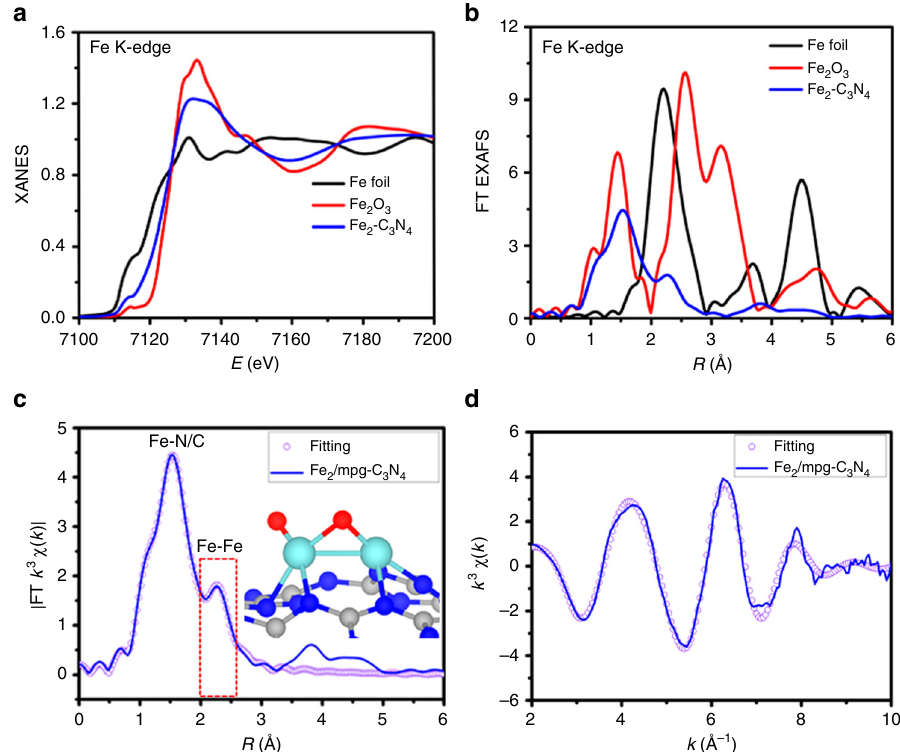
Fig. 2 X-ray absorption analysis of Fe K-edge. a XANES spectra at the Fe k-edge of Fe 2 /mpg-C 3 N 4 , Fe 2 O 3 , and Fe foil. b Fourier transform (FT) at the Fe k- edge of Fe 2 /mpg-C 3 N 4 , Fe 2 O 3 , and Fe foil. c , d Corresponding fi ts of the EXAFS spectrum of Fe 2 /mpg-C 3 N 4 at R space and k space, respectively. The inset of c is the schematic model of Fe 2 /mpg-C 3 N 4 (Fe cyan, O red, N blue, and C